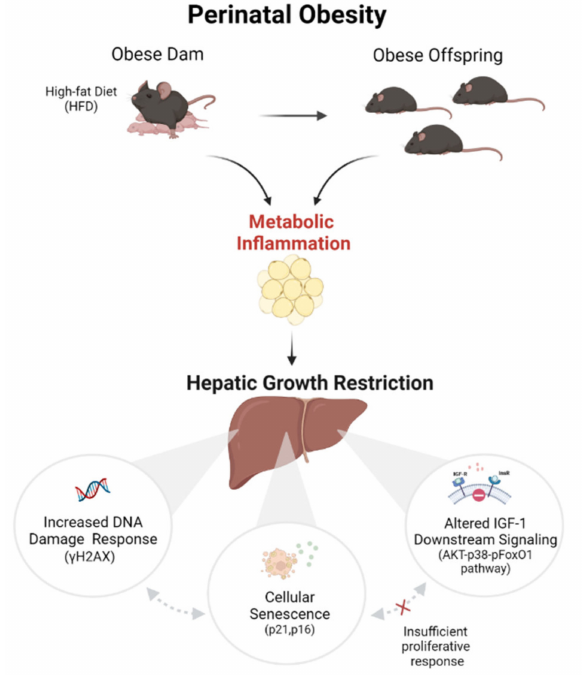
Figure 7. Working model. Proposed working model illustrating possible mechanisms by which perinatal obesity causes hepatic growth restriction: HFD-induced maternal obesity induces an obese body composition with increased expression of Il6 in white adipose tissue (WAT). This WAT-related inflammatory response is linked to active hepatic STAT3 signaling and hepatic growth restriction in the offspring in early life (postnatal day 21, P21). Based on an unbiased proteomic analysis we identified three molecular mechanisms that might contribute to the hepatic growth restriction after perinatal obesity: (1) an increased DNA damage response (DDR), (2) hepatocellular senescence, and (3) inhibition of insulin/IGF-1-mediated AKT-pFoxO1 signaling, resulting in an inadequate compensatory proliferative growth response. These findings let us speculate that perinatal obesity induces aging-related processes and could cause premature liver aging with hepatic growth restriction in the offspring. Created with